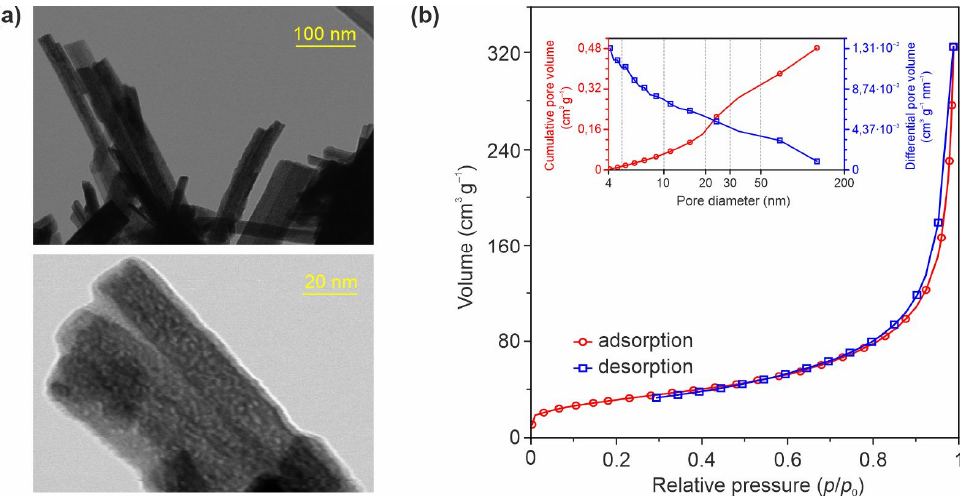
Figure 3. ( a ) Microphotographs in STEM mode at different magnification, ( b ) nitrogen adsorp- tion/desorption isotherms at 77 K, and (inset) cumulative pore volume and pore size distribution curves for TO-Ni-05